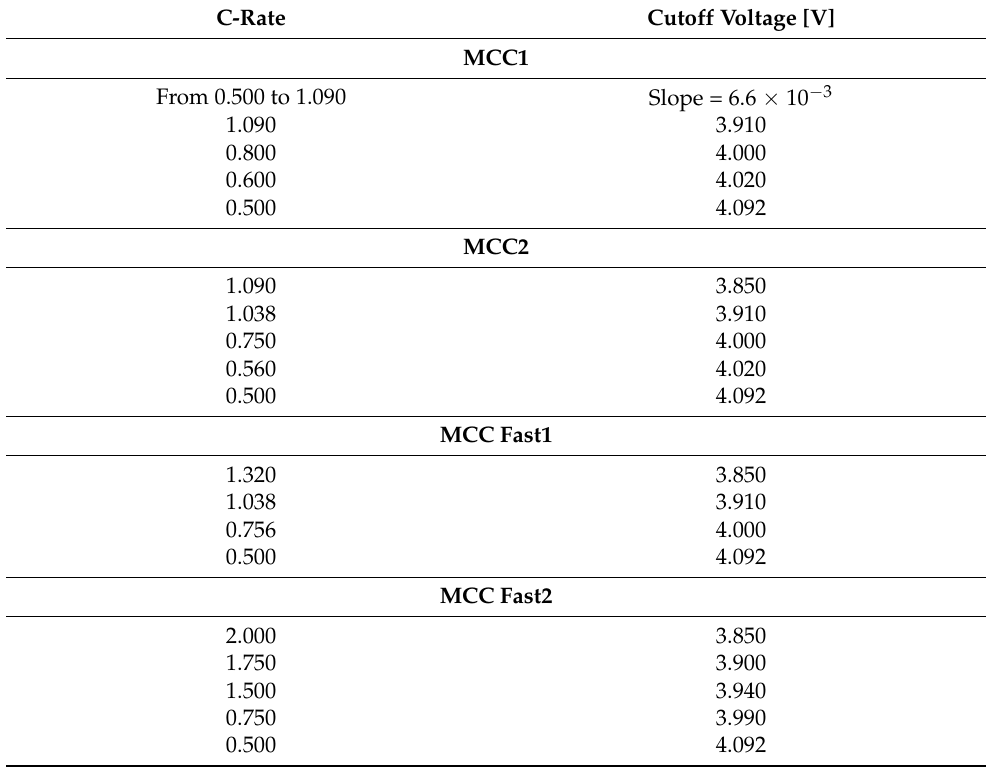
Table 3. Summary of the four MCC